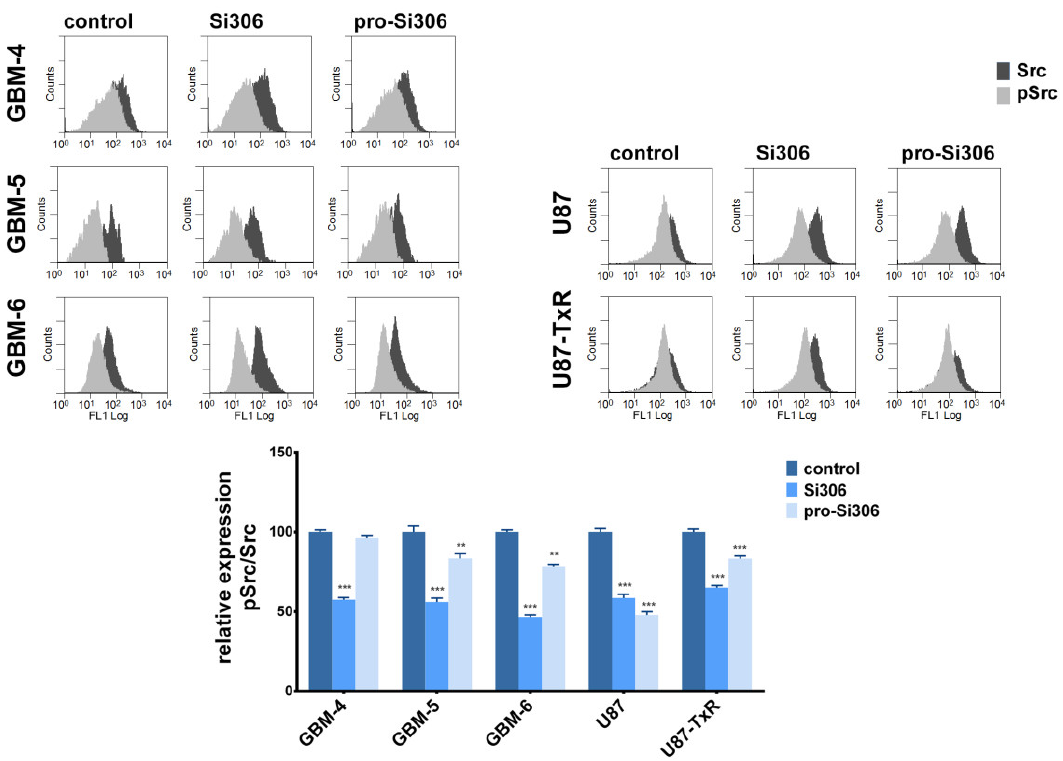
Figure 7. Si306 and pro-Si306 inhibit Src activity in primary GBM cells. Flow-cytometric profiles of Src and pSrc expression in primary GBM, U87, and U87-TxR cells treated with Si306 and pro-Si306. GBM-4, GBM-5, and GBM-6 cells were treated with 10 µM Si306 and pro-Si306 for 24 h, while U87 and U87-TxR cells were treated with 5 µM Si306 and pro-Si306 for 24 h. Histogram represents relative pSrc/Src expression. Values are expressed as mean ± SEM. Statistical significance between treated and control group is shown as ** ( p < 0.01), and *** ( p < 0.001).